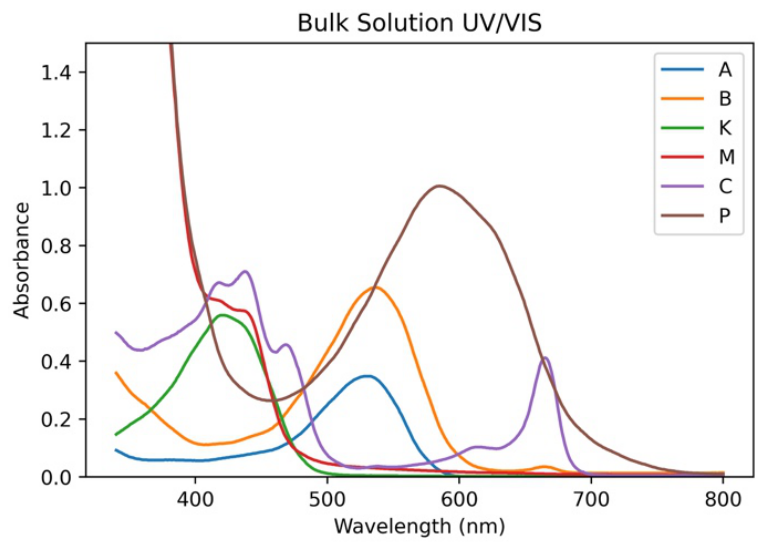
Figure 5. UV-Vis spectra of the six constituent dyes (10 μM concentration).